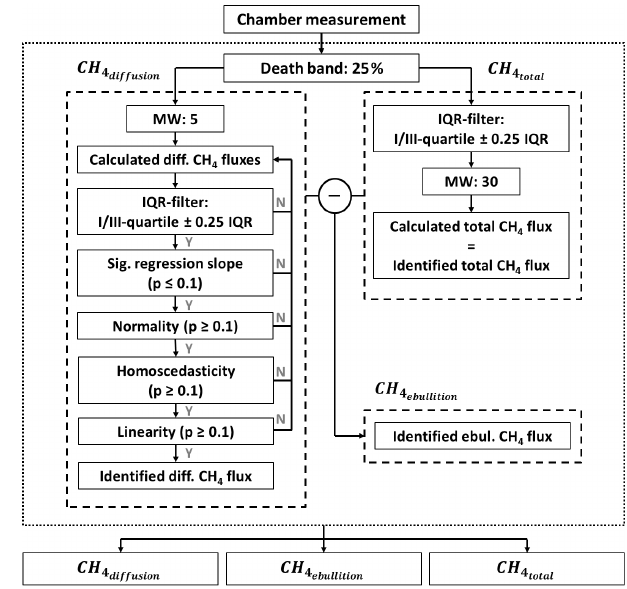
Figure 2. Flow chart showing the principles of the calculation of CH 4 and CH 4 (dashed boxes) as well as subsequent CH 4 diffusion total flux separation (dotted box). size of 5 (CH 4 ; user defined) and 30 consecutive diffusion